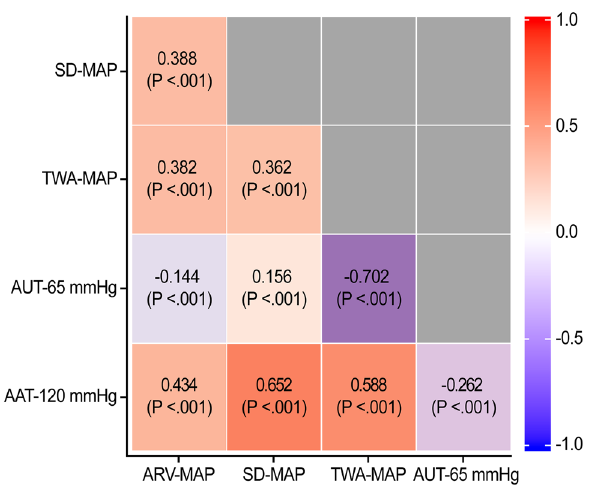
Figure 3. Heat map showing the correlations among mean arterial pressure parameters. The squares show the correlation coefficients (− 1 to 1), with P values, between the variables according to row and column. The red and blue show positive and negative correlations, respectively. ARV, average real variability; SD, standard deviation; TWA, time-weighted average; MAP, mean arterial pressure; AUT, area under threshold; AAT, area above threshold.